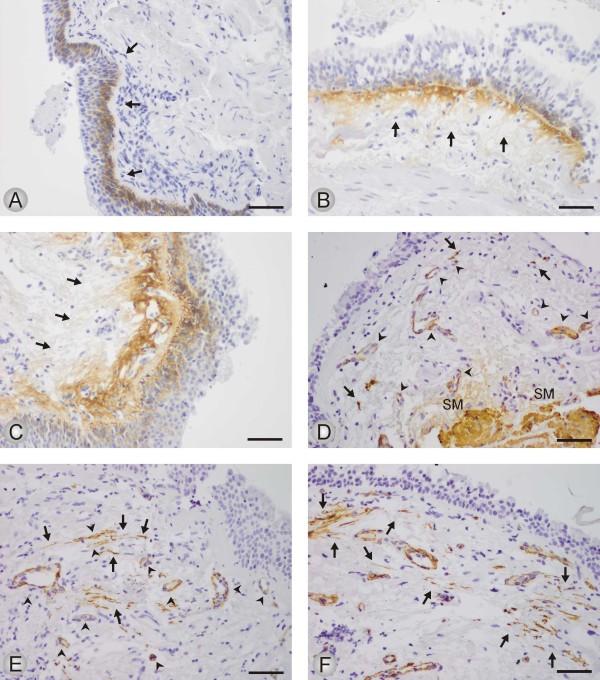
The immunohistochemical expression of Tn-C (1 A-C) and α-SMA (1 D-F) in bronchial biopsies from study subjects. The figures show representative microphotographs from each category. A: Positivity for Tn-C is seen in tangentially sectioned basal epithelial cells and along the basement membrane (BM) of bronchial epithelium (arrows); scale bar = 0.05 mm. B: Tn-C positivity in basal epithelial cells and in the stroma underneath the BM (arrows); scale bar = 0.05 mm. C: Positivity for Tn-C in basal epithelial cells and in a wide area of stromal connective tissue underneath the BM (arrows); scale bar = 0.05 mm. D: Spindle shaped cells positive for α-SMA (arrows) in a biopsy graded to the category 1-4 positive cells. Smooth muscle of the bronchial wall (SM) or blood vessels (arrow heads) were not counted; scale bar = 0.05 mm. E: A bronchial biopsy graded to the category 5-10 α-SMA positive cells (arrows). Blood vessels (arrow heads) or smooth muscle layer of the bronchial wall (SM) were not counted; scale bar = 0.05 mm. F: More than 10 spindle shaped cells are showing positivity for α-SMA (arrows) in a bronchial biopsy; scale bar = 0.05 mm.